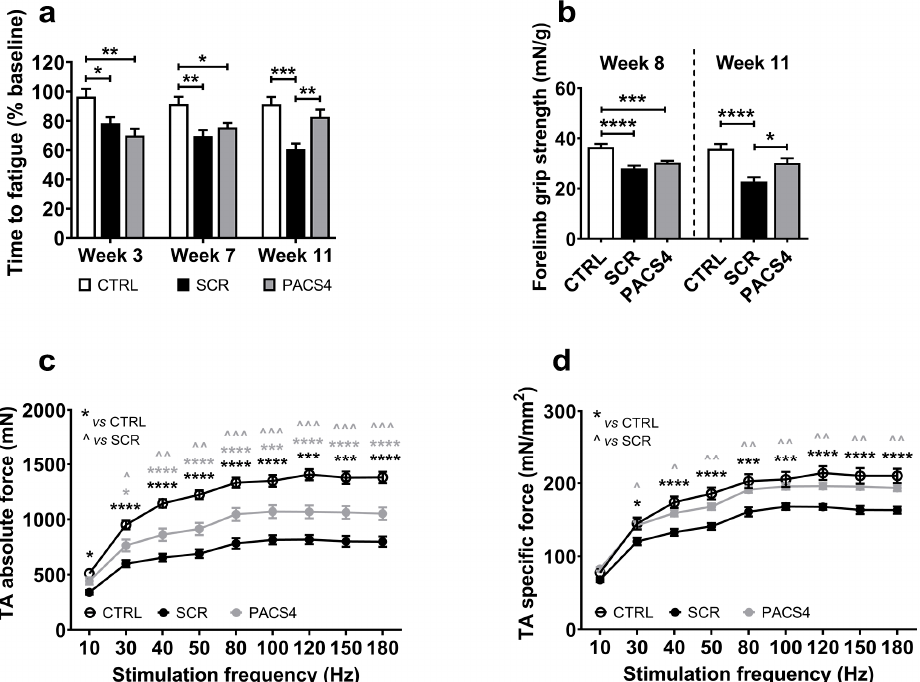
Figure 2. Significant enhancement in muscle function following vivoPMO-PACS4 treatment. ( a ) Treadmill exhaustion tests were conducted 1 week before the first TMX injection, and at weeks 3, 7 and 11. The time to fatigue is the total running time in each test, expressed as percentage of the initial time. ( b ) Forelimb grip strength tests were carried out on weeks 8 and 11. Data are shown as the force corrected to the bodyweight recorded at the assessment. ( c ) In situ absolute force of TA muscles was measured while animals were under terminal anesthesia on week 12. ( d ) Specific mus- cle force is displayed as a ratio of the absolute force and the muscle cross-sectional area (CSA), mathematically approximated by dividing the muscle mass by the optimum fiber length and the density of mammalian muscle. Data are shown as means ± SEM; n = 6. Statistical analysis was by ( a , b ) one-way or ( c , d ) two-way ANOVA followed by Tukey’s multiple comparisons test; */^ p < 0.05, **/^^ p < 0.01, ***/^^^ p < 0.001, **** p < 0.0001. In ( c , d ), black asterisks indicate significance between the SCR and CTRL groups; grey asterisks or carets indicate significance between the PACS4 and CTRL or the PACS4 and SCR groups, respectively. Table 2. Changes in mouse locomotor behavior after longitudinal vivoPMO treatment.